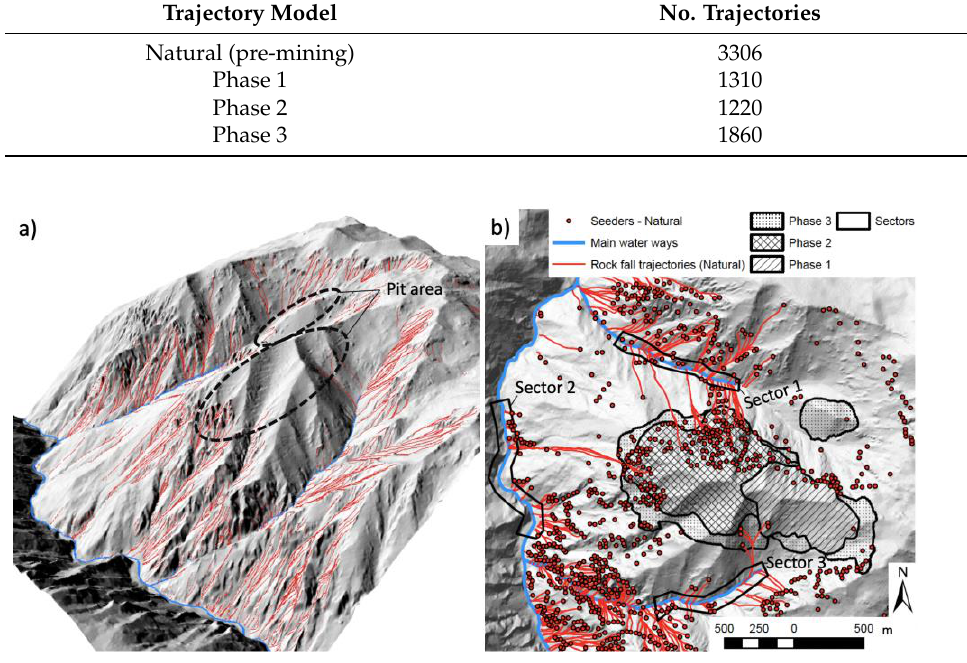
Figure 8. 3-dimensional rendering ( a ) and plan view ( b ) of rockfall trajectories for naturally occurring rockfalls (pre-mining).